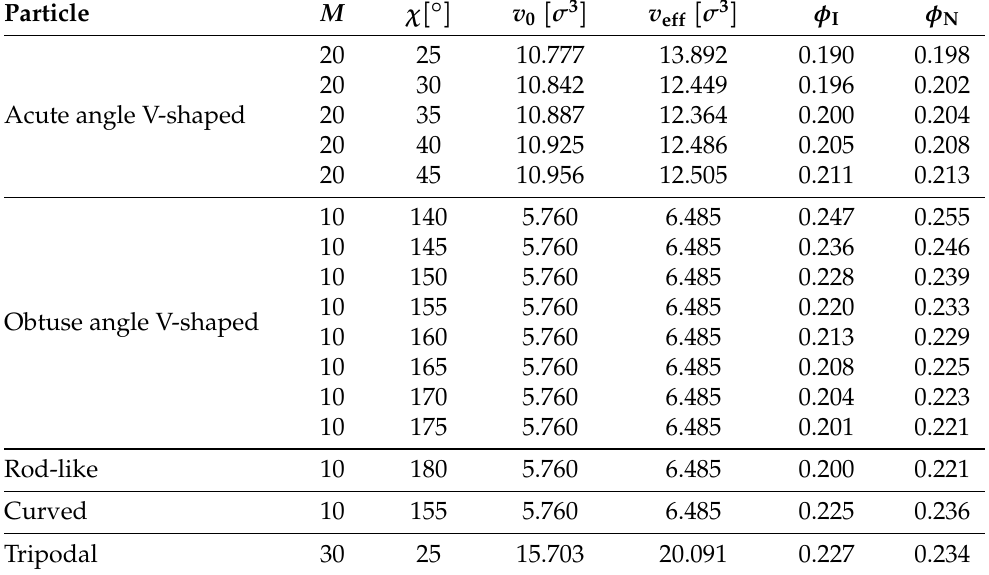
Table 1. Geometric parameters of the particles investigated in this work (number of segments M , bend angle χ , geometrical volume v 0 , effective v eff volume); packing fractions at the isotropic-nematic coexistence, in the isotropic, φ I , and in the nematic phase, φ N .